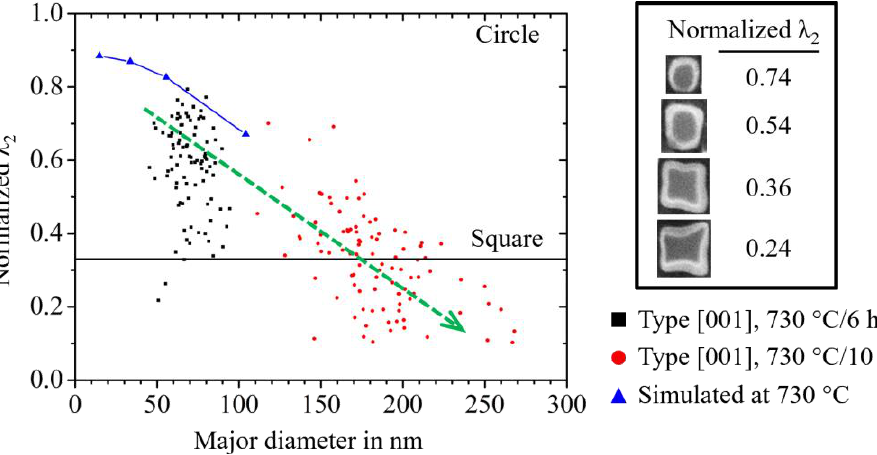
Figure 13. Study on the size-dependence of the in-plain shape of γ″ particles. Plot of the normalized λ 2 value for particles of orientation type [001] as a function of the major diameter for the SEM- investigations, shown in Figures 9 and 10. This is compared to respective results from the 3D phase-field simulation study presented in Figure 8a.